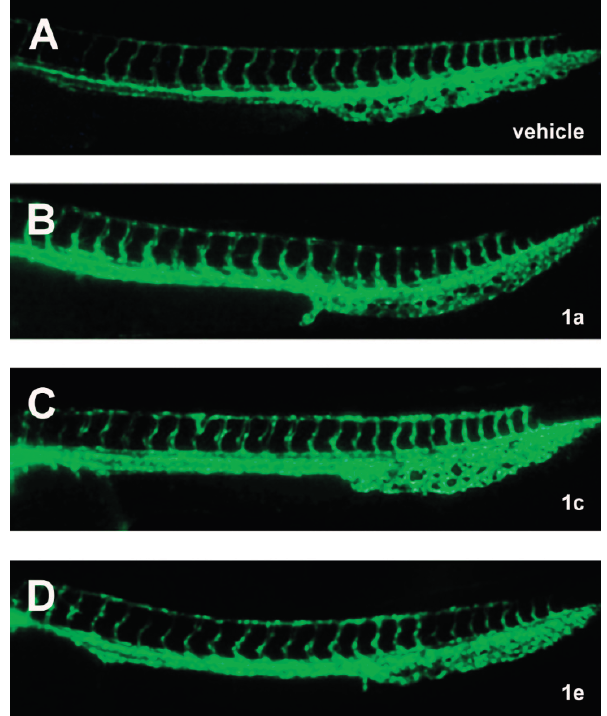
Figure 3. Chalcone derivatives had no effect on the formation of angiogenic intersegmental vessels (ISVs). ( A – D ) Representative images of zebrafish trunk ISVs treated with 3 ppm of chalcone and its derivatives (in 0.12% DMSO) via exposure method I. All figures are lateral views with dorsal to the top and anterior to the left. The fluorescent vessels of embryos were observed at 36 hpf. Vehicle: 0.12% DMSO